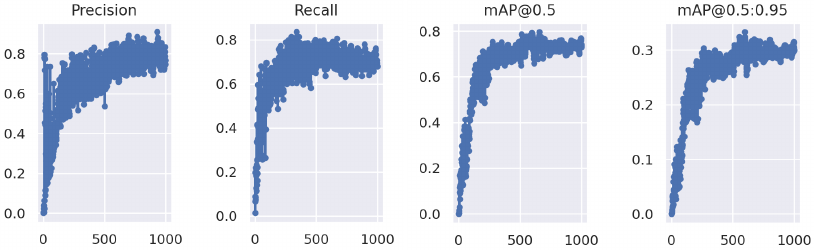
Figure 9. The curve of the mAP. The abscissa is the number of the iterations. Furthermore, the y -axis is the value of the prediction, recall, mAP@0.5, and mAP@0.5:0.95.